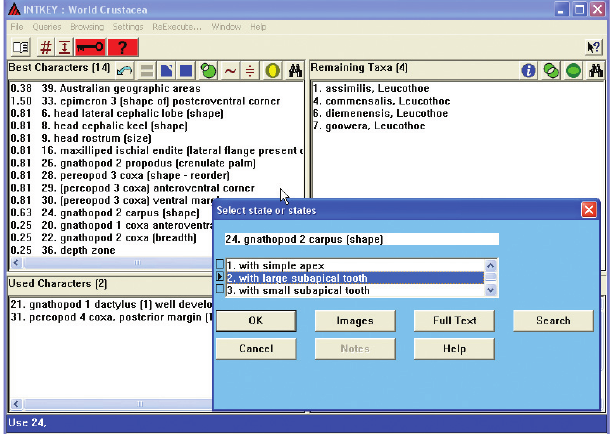
Figure 68. Character 24 again splits the Remaining Taxa into two equally large groups.